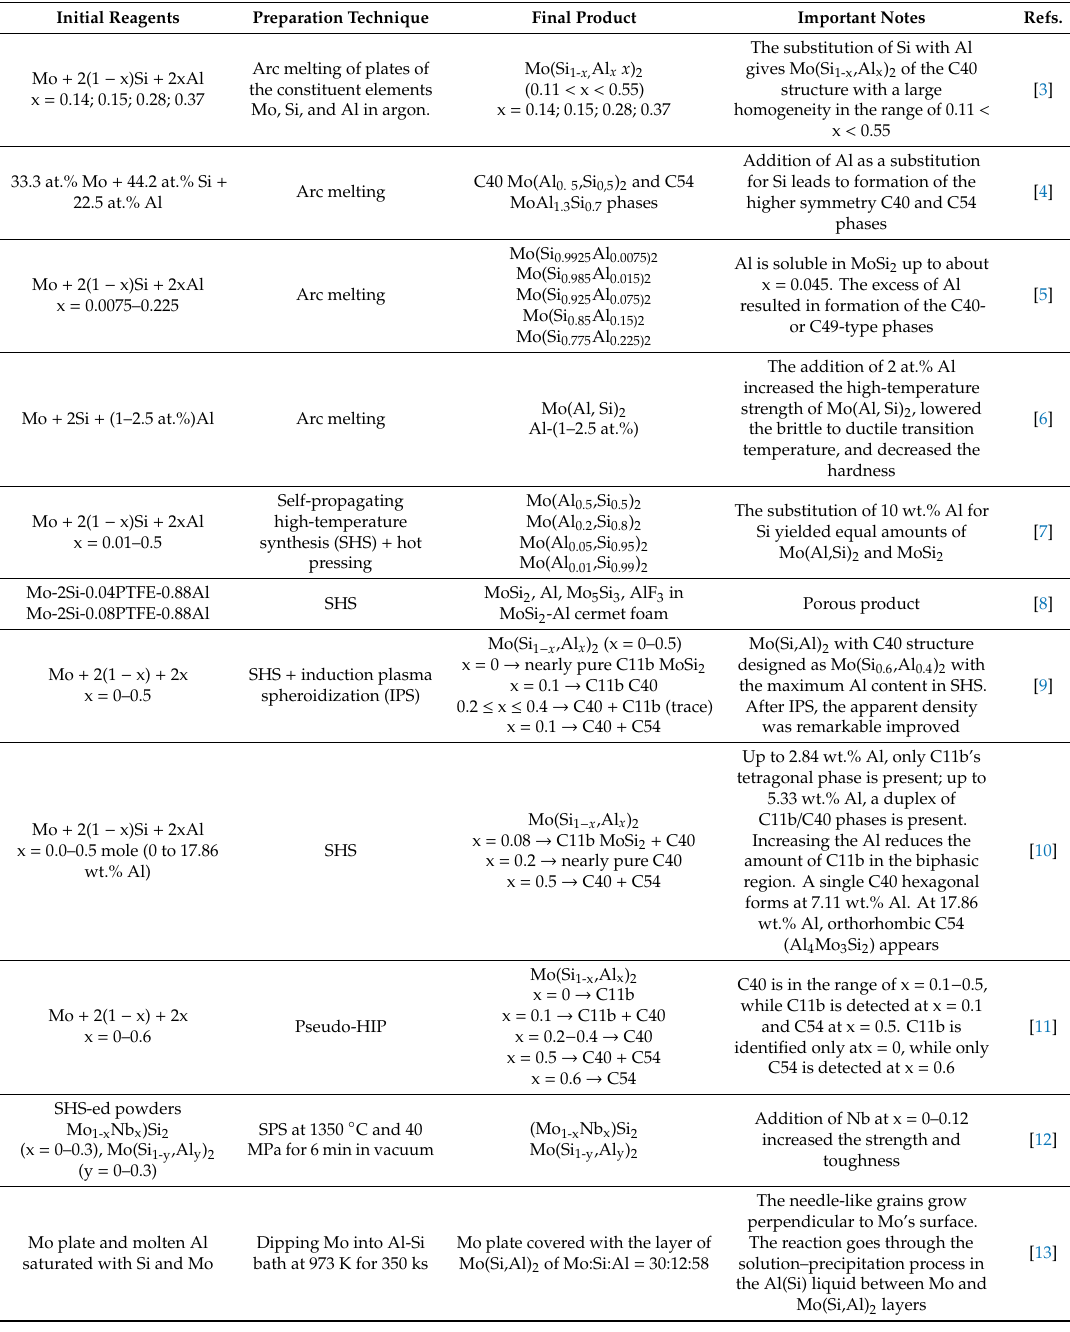
Table 1. Methods of Mo(Si,Al) 2